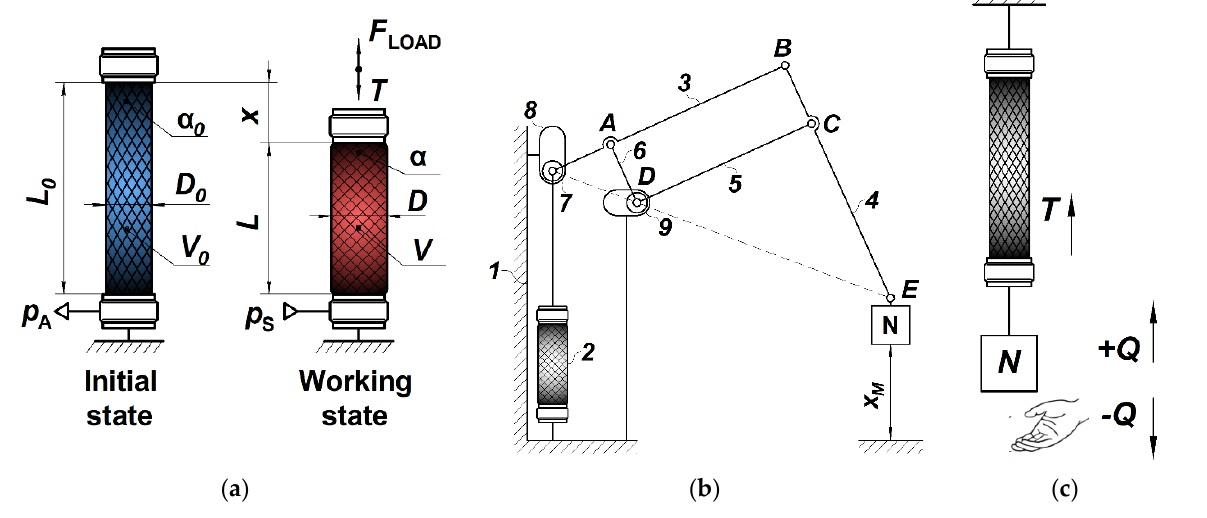
Figure 3. The schemes of the PAM-based drive: ( a ) principle of operation of the PAM-based drive; ( b ) the kinematic scheme of the PAM-based manipulator; ( c ) the calculation model for the mode of load positioning by the operator force.